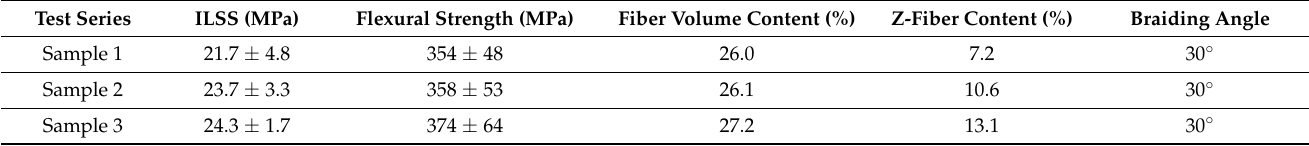
Table 5. Interlaminar shear strength and 3-point bending strength of OFCs with 3D braid